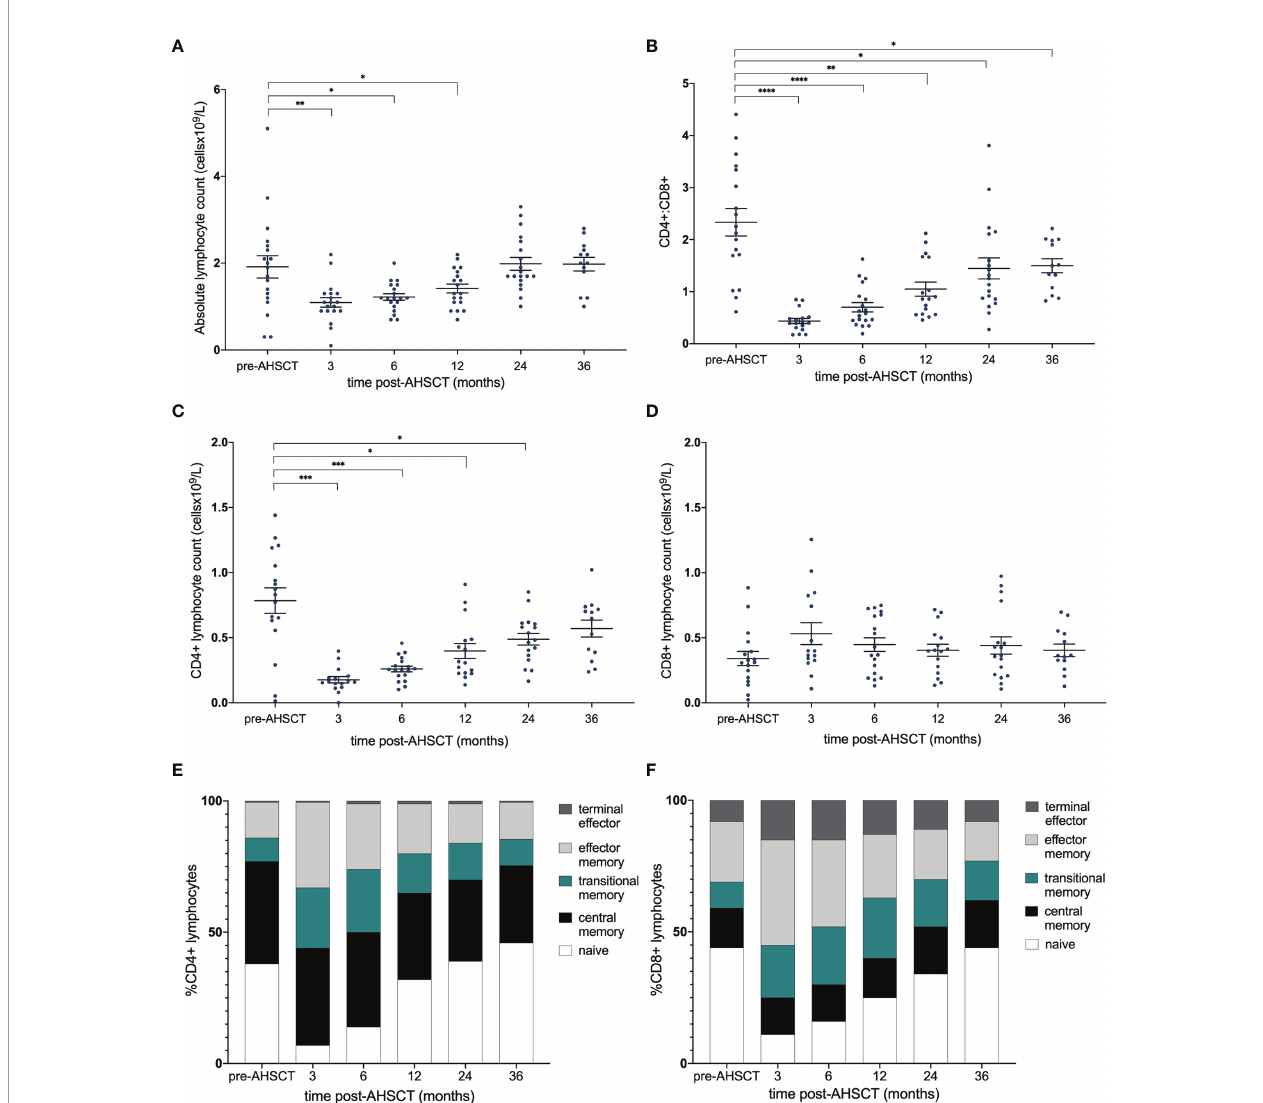
FIGURE 1 | Immune reconstitution following AHSCT. (A) Absolute lymphocyte count (x10 9 /L) and (B) CD4+:CD8+ ratio pre- and post-transplant. (C) CD4+ and (D) CD8+ populations [cell count (x10 9 /L)] and stacked bar graph of the proportions of (E) CD4+ and (F) CD8+ subsets within the repertoire at each time point. (A) Wilcoxon signed-rank test was used to compare all time points to baseline, accounting for the reduction in patient numbers at 36 months. (B – D) A linear mixed model was used to detect signi fi cance (p <0.05) between each time point with the pre-transplant (control) sample. Holm-Sidak ’ s multiple comparison test was applied, accounting for the reduction in patient numbers at 36 months. *p < .05, **p < 0.025, ***p < 0.005, ****p <